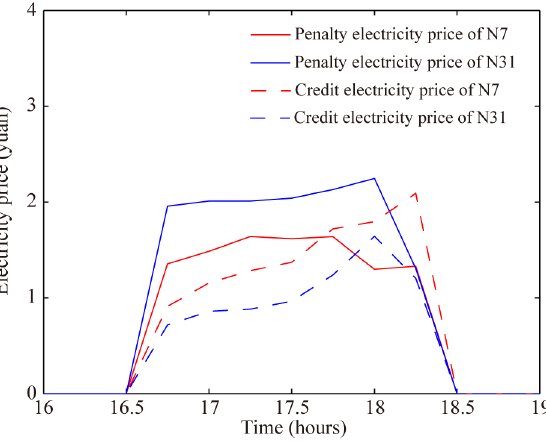
Figure 16. Comparison between penalty electricity price and credit electricity price.